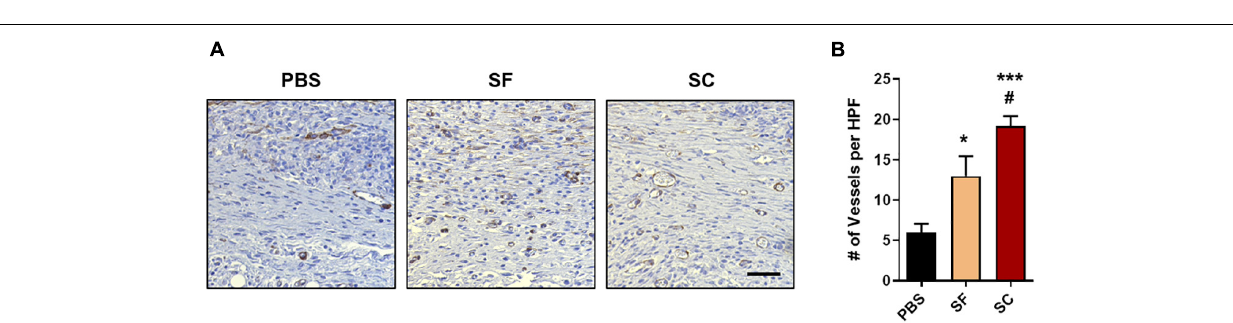
FIGURE 6 | In vivo angiogenesis evaluation with the immunohistochemical staining (IHC) of alpha-smooth muscle actin ( α -SMA). (A) Representative light microscopy images at regenerated wounds (Scale bar = 100 µ m). (B) The number of newly formed vessels in the high-power field (HPF) magnification images ( n = 10–15) (*compared with the PBS group; # compared with the SF group; ∗ , # p < 0.05; *** p <